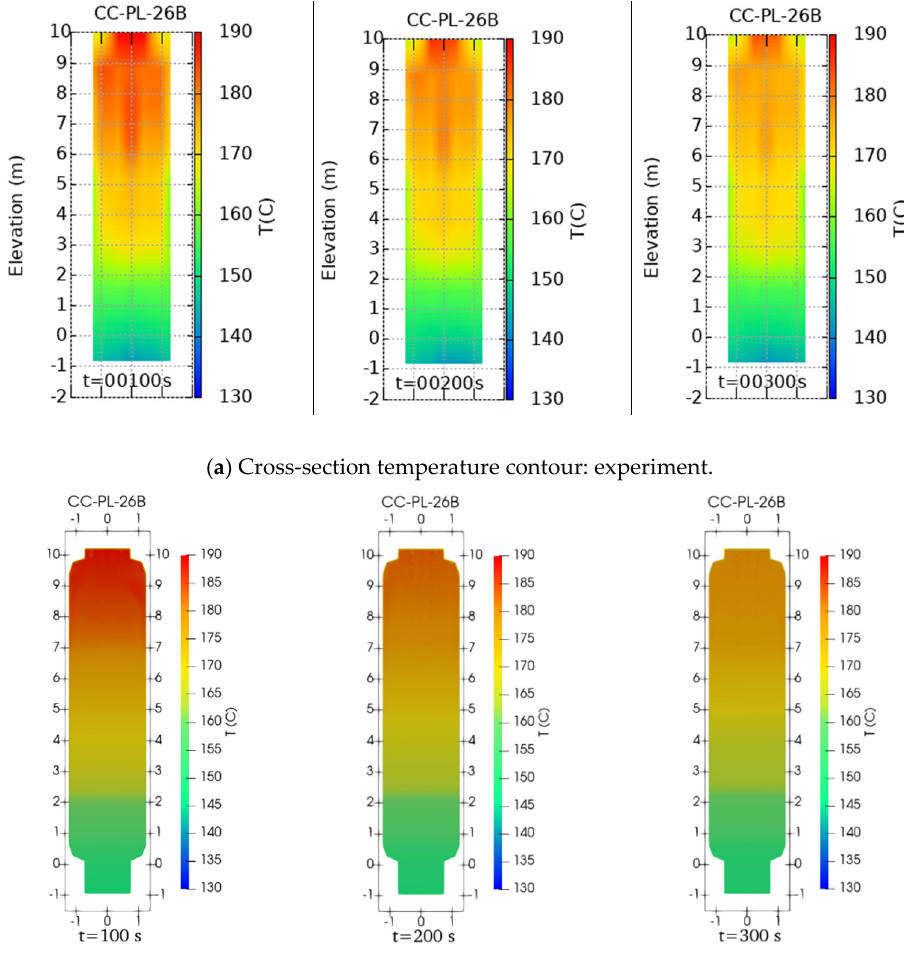
Figure 14. Comparison of the temperature contour on the cross-section as ( a ) measured and ( b ) numerically predicted by means of the SST k-ω turbulence model with CHT before water injection in the upper pool and middle jacket.